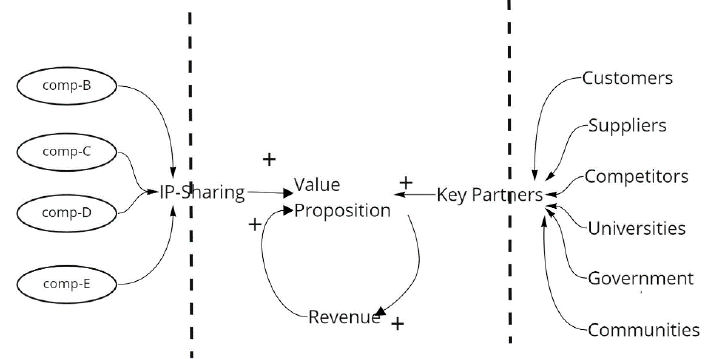
Figure 12. Generic BMI for OI ecosystem.